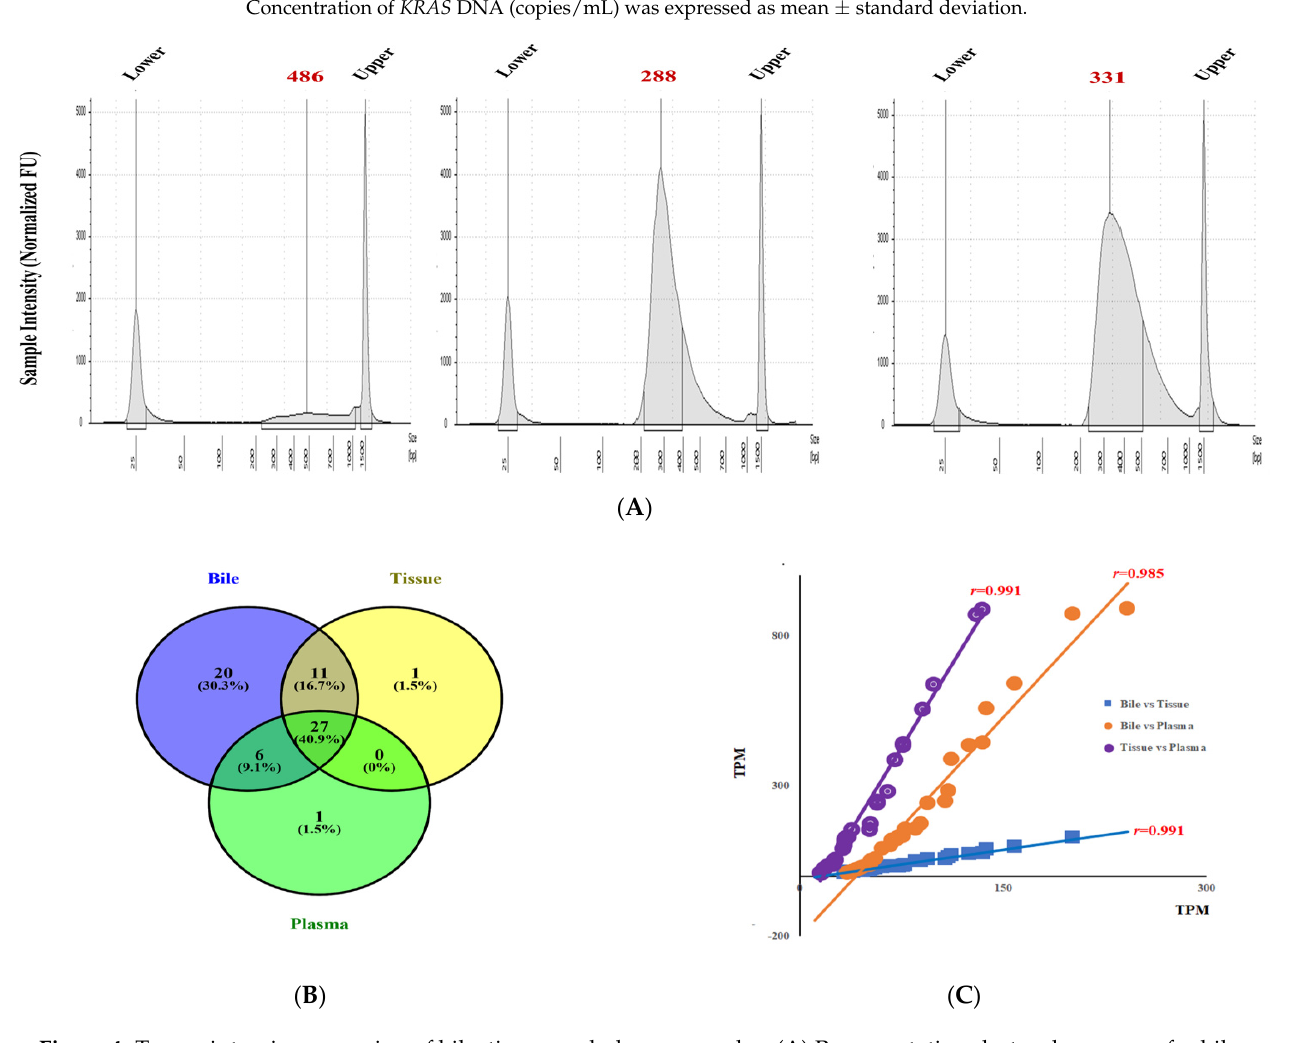
Figure 4. Transcriptomic sequencing of bile, tissue, and plasma samples. ( A ) Representative electropherograms for bile, paired tissue, and plasma mRNAs detected with an Agilent 2100 Bioanalyzer. ( B ) Venn diagram of the number of KRAS - associated mRNAs expressed in bile, paired tissue, and plasma samples from BTC patients, which were analyzed separately. ( C ) Scatter plot of the correlation matrix for expression of 66 KRAS -associated oncogenes evaluated in bile, paired tissue, and plasma samples (from patient CA34). Each dot represents the transcripts per million read (TPM).